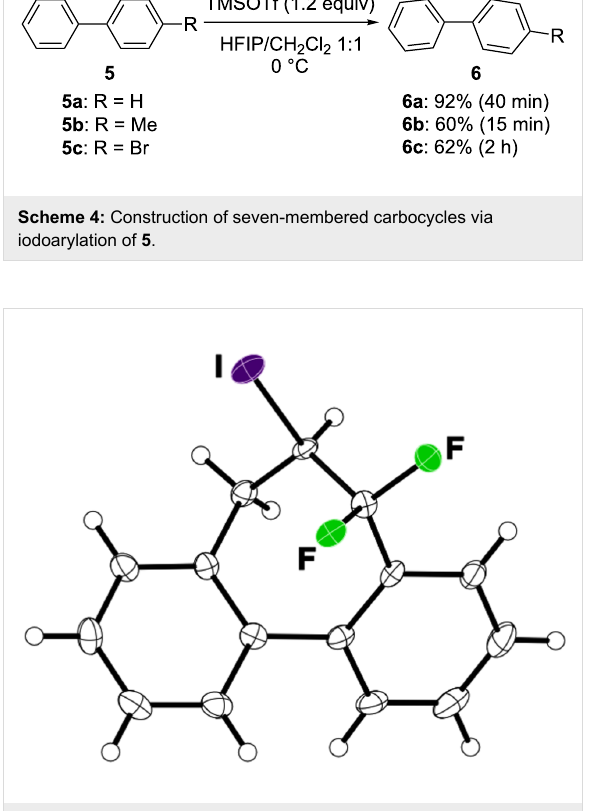
Figure 2: ORTEP diagram of 6a with 50% ellipsoid